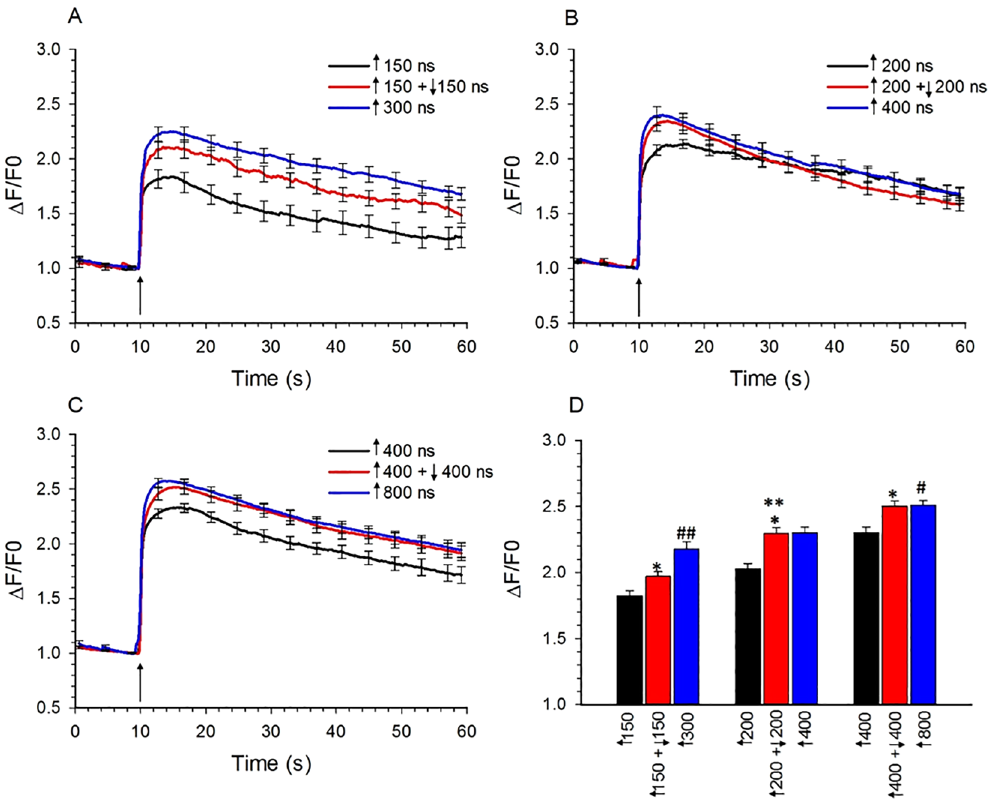
Figure 2. Comparison of the effect of unipolar pulses vs symmetrical bipolar pulses on [Ca 2 + ] i . ( A ) Averaged cell responses ± s.e.m. (n = 17–60) for the rise in [Ca 2 + ] i in cells exposed to a unipolar pulse of 150 ns and 300 ns, and to a bipolar pulse with each phase lasting 150 ns. The E-field amplitude for each phase was 3.1 kV/ cm and the arrow indicates when the pulse was delivered to the cells. ( B ) Same as in ( A ) except that cells were exposed to a unipolar pulse of 200 ns and 400 ns, and to a bipolar pulse with each phase lasting 200 ns (n = 30– 35). ( C ) Same as in ( A ) except that cells were exposed to a unipolar pulse of 400 ns and 800 ns, and to a bipolar pulse with each phase lasting 400 ns (n = 21–35). ( D ) Bar graph showing the mean ± s.e.m. for the maximal increase in [Ca 2 + ] i for the responses shown in ( A – C ). * p < 0.05, significantly different from the corresponding unipolar pulse; ** p < 0.01, significantly different from ↑ 150 + ↓ 150 and ↑ 400 + ↓ 400 bipolar pulse. # p < 0.01, Significantly different from ↑ 150 + ↓ 150 and ↑ 200 + ↓ 200 bipolar pulse. ## p < 0.01, Significantly different from ↑ 150 + ↓ 150 bipolar